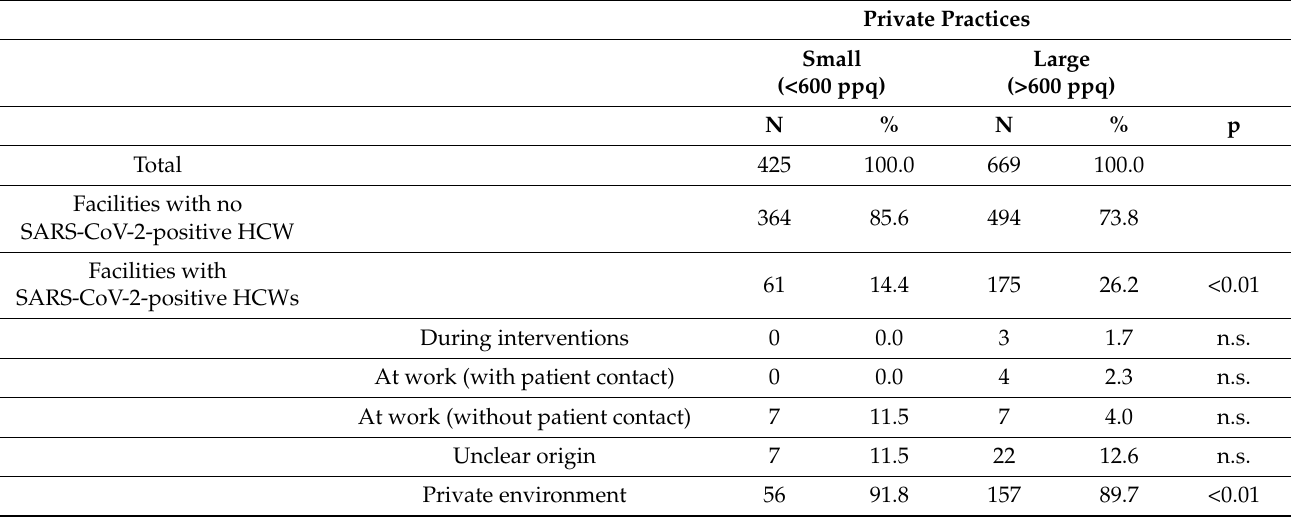
Table 3. Assumed source of infection for healthcare workers.